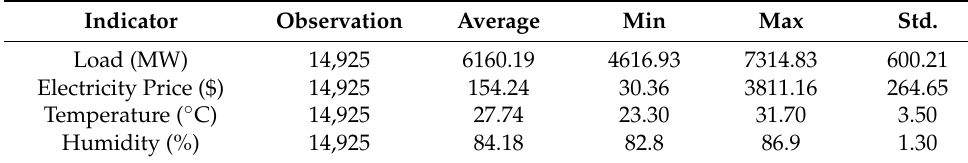
Table 1. The descriptive statistics of the data.